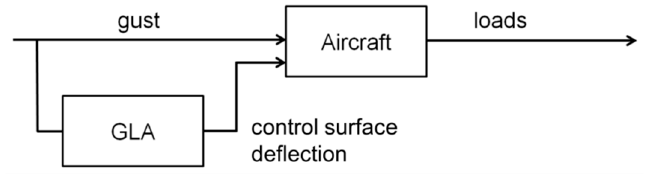
Figure 13. Block diagram of the GLA algorithm.